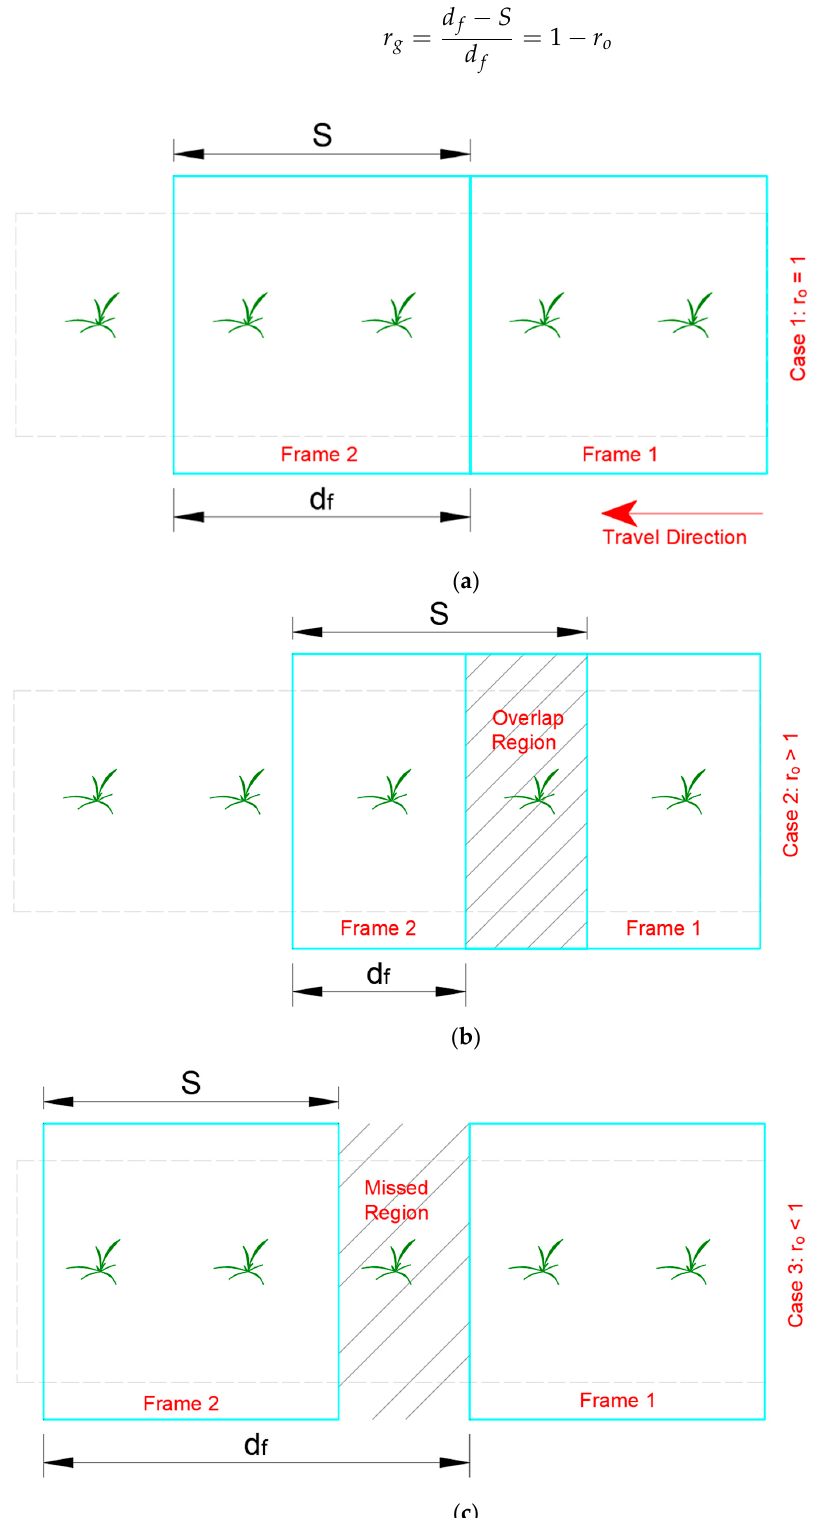
Figure 2. Relative positions of two consecutive processed frames of a vision system: ( a ) r o = 1 since d f = S , resulting in frames with unique bounded regions; ( b ) r o > 1 since d f < S , resulting in overlap region ( b ); and ( c ) r o < 1 since d f > S , resulting in missed